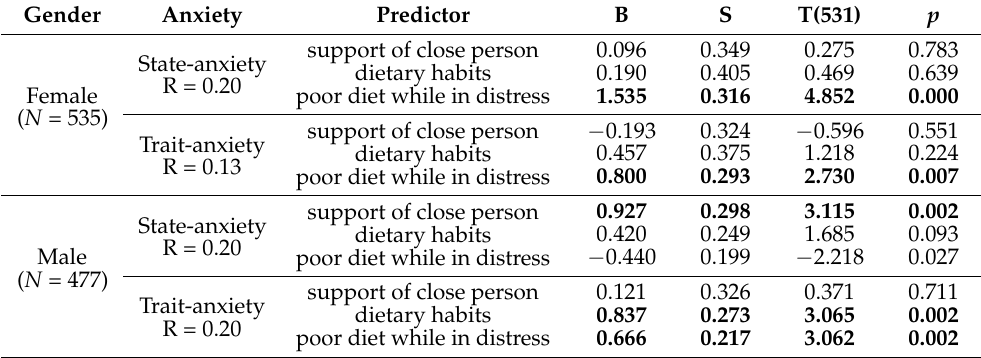
Table 2. Regression models grouped by gender of participants ( p <